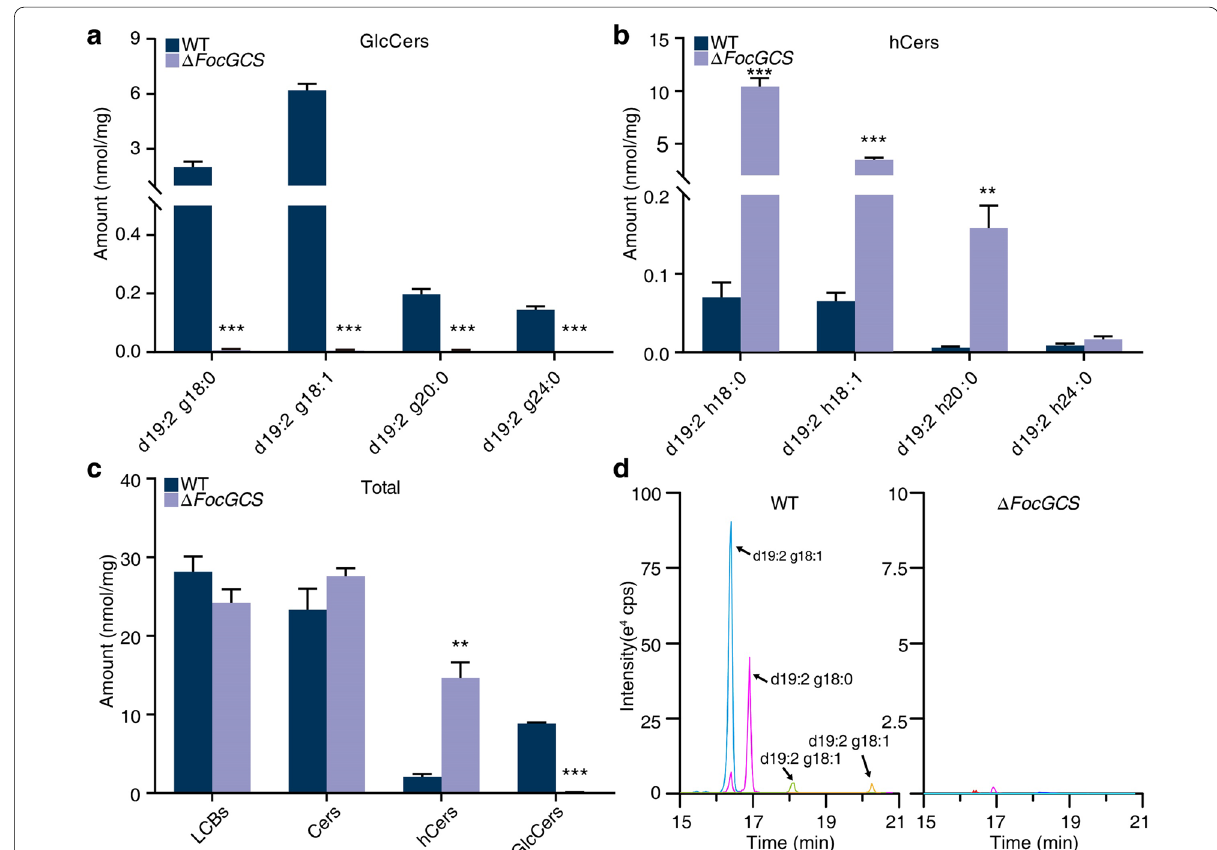
Fig. 4 Contents of glucosylceramides (GlcCers), hydroxyceramides (hCers), ceramides (Cers), and long chain bases (LCBs) in the WT and ∆ FocGCS strains measured using HPLC–MS/MS. a Main glucosylceramide (GlcCer) levels in the WT and ∆ FocGCS strains. b Main hydroxyceramide (hCer) levels in the indicated strains. c Total sphingolipid levels, including total LCBs, Cers, hCers, and GlcCers, in the indicated strains. d HPLC–MS/MS chromatograms showing main glucosylceramide retention in cultures of the indicated strains. The mean values independent experiments, and asterisks indicate significant differences from the WT group (Student’s t ‑test, ** P < 0.01, *** P <